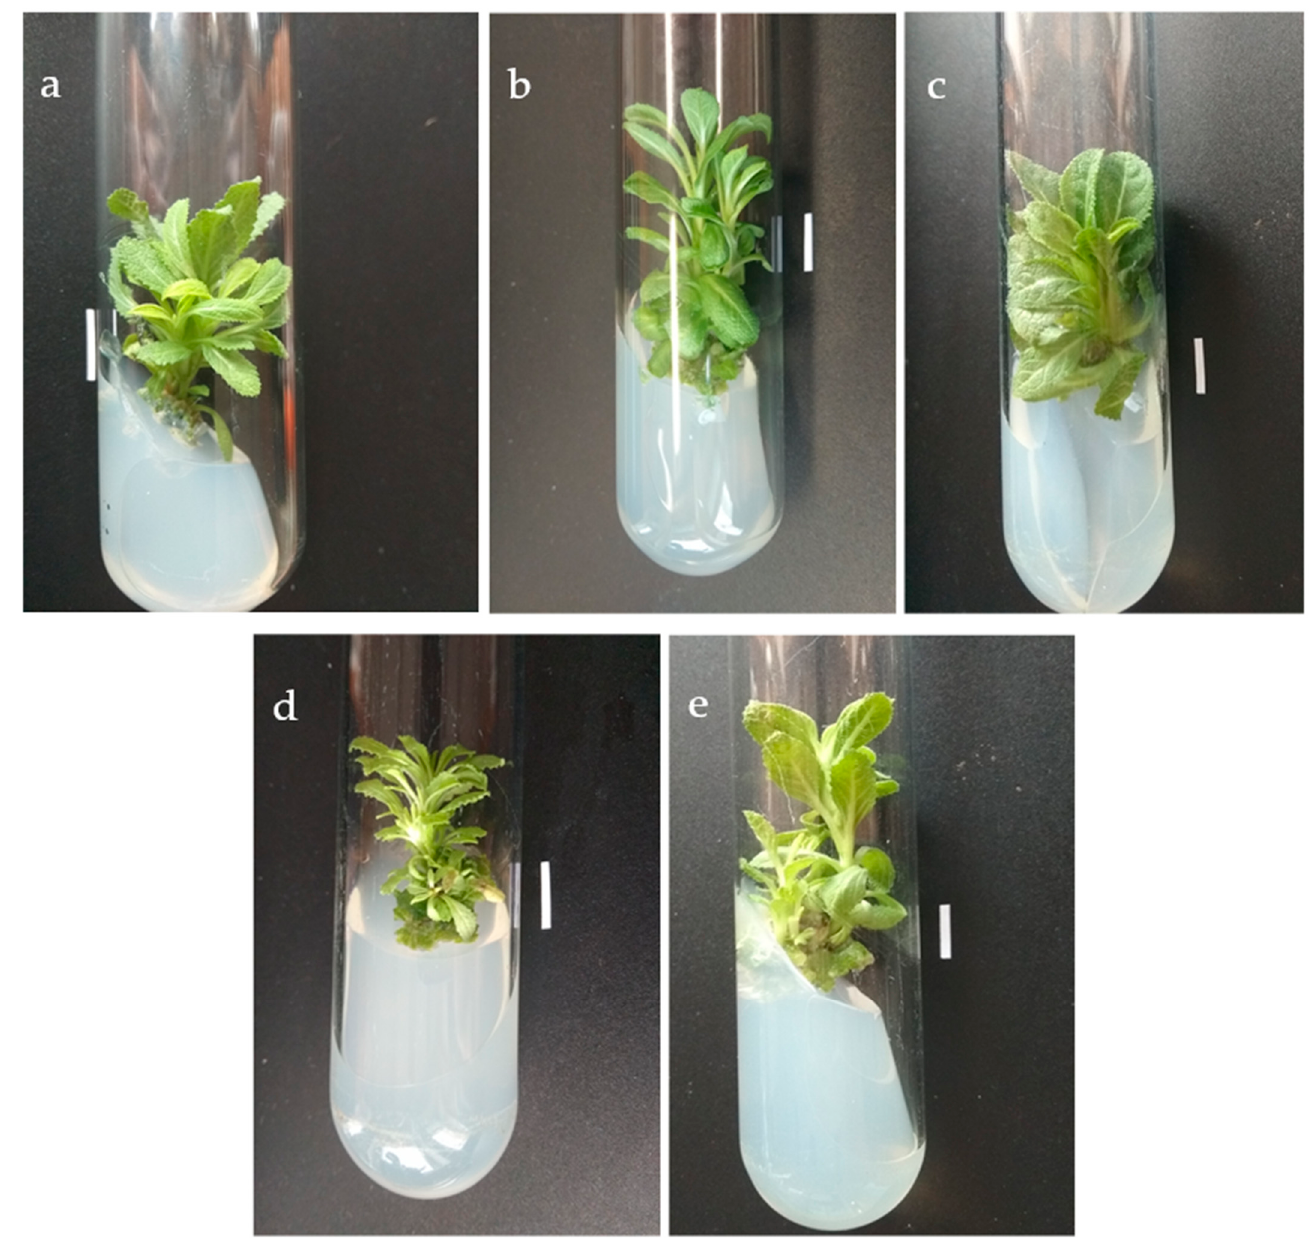
Figure 2. Regenerated shoot line obtained in the presence of different cytokinin: 2 mg/L BAP ( a ), 2 mg/L mT ( b ), 0.2 mg/L TDZ ( c ) and 4 mg/L CPPU ( d ), and control shoot culture ( e ) of S. bulleyana after 5 weeks on MS medium with 0.1 mg/L IAA and 1 mg/L BAP (passage 10). Bar 1cm. Table 3. Evaluation of morphogenic potential of S. bulleyana shoot lines obtained in the presence of different cytokinin and control shoot culture after year (passage 10).